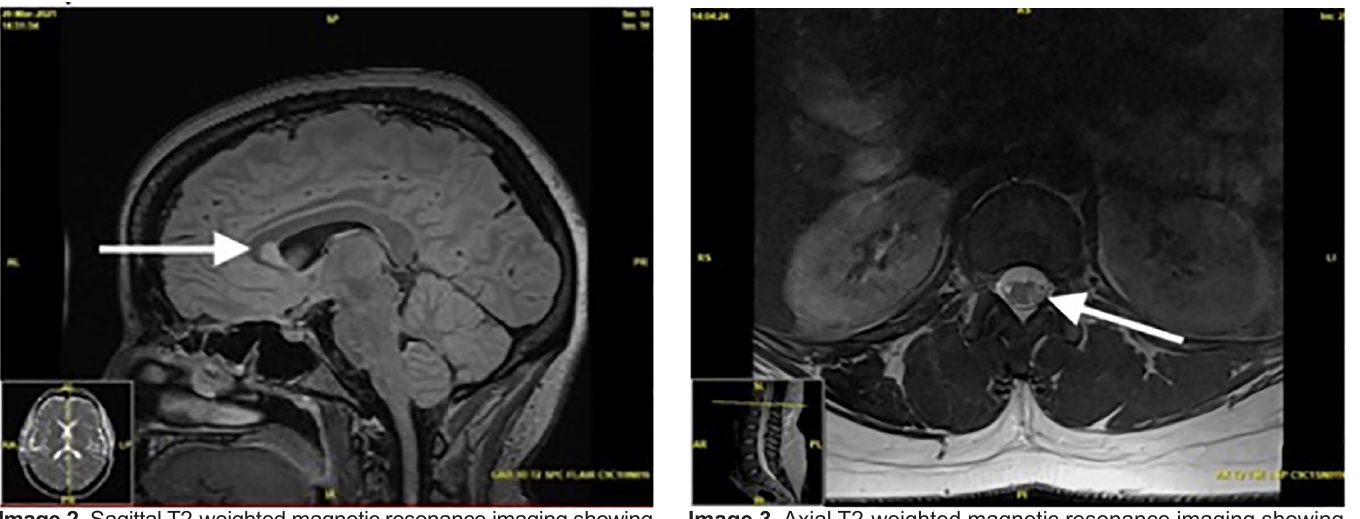
Image 2. Sagittal T2-weighted magnetic resonance imaging showing periventricular hyperintensity characteristic of multiple sclerosis.